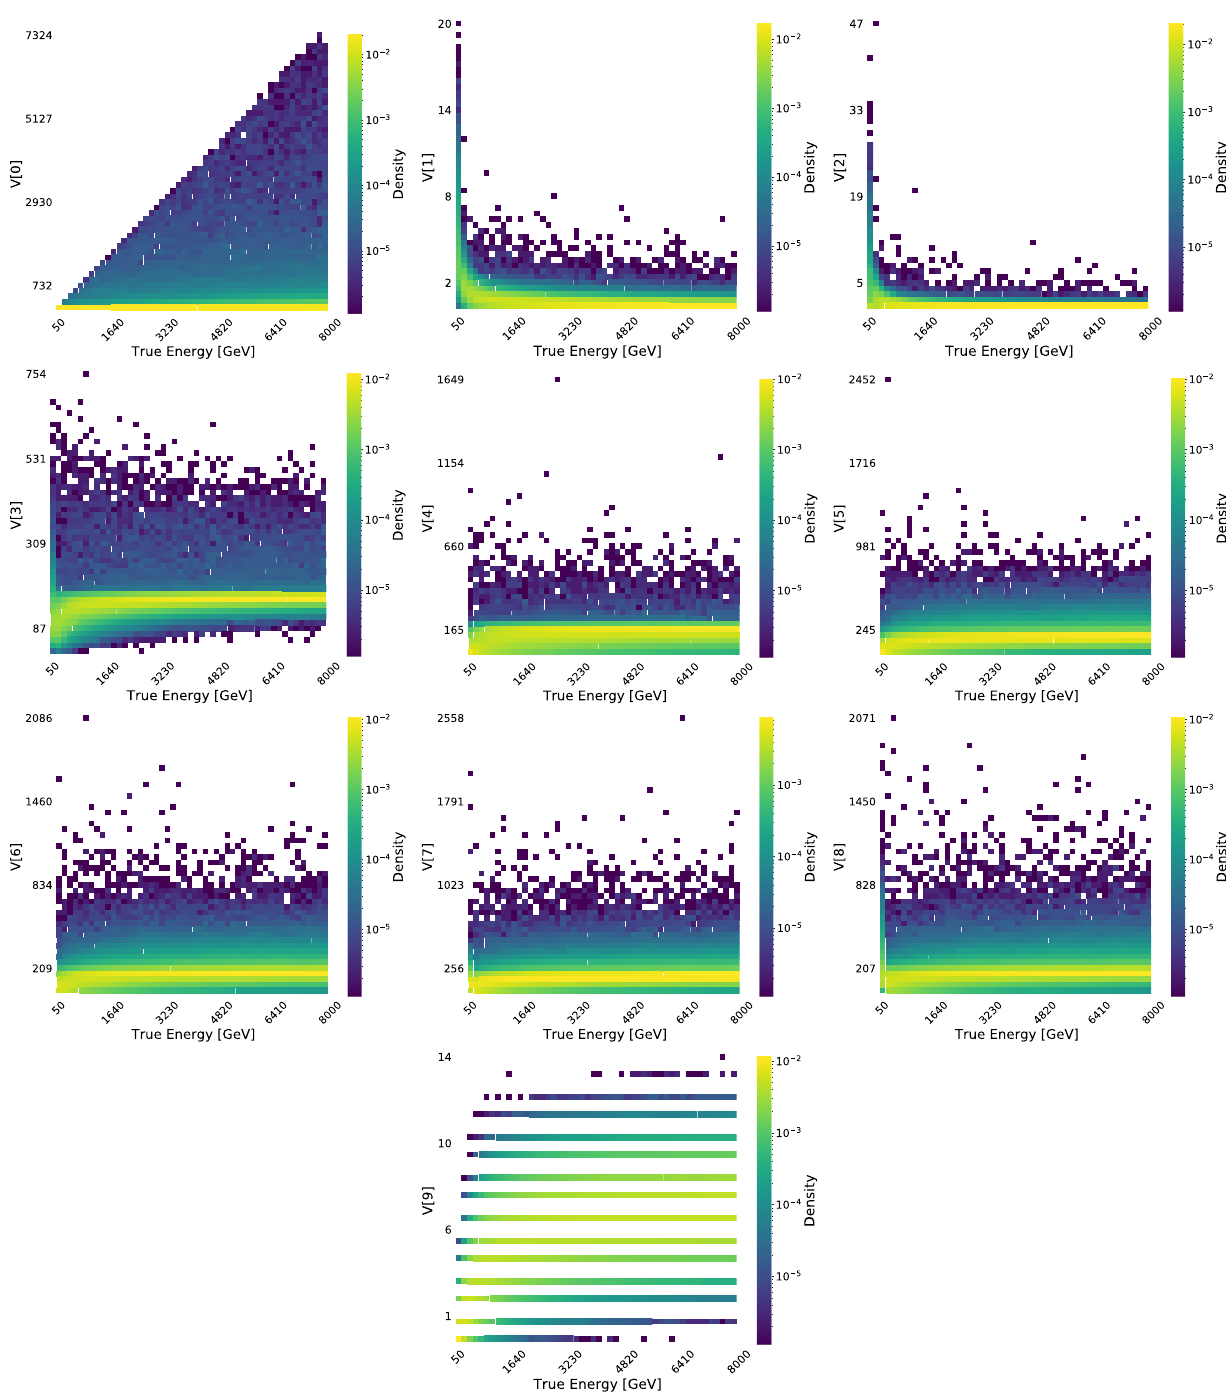
Fig. 18 2D histograms showing the dependence of features V[0] to V[9] (on the y axes) on true muon energy (on the x axes). Features are defined in Sect.